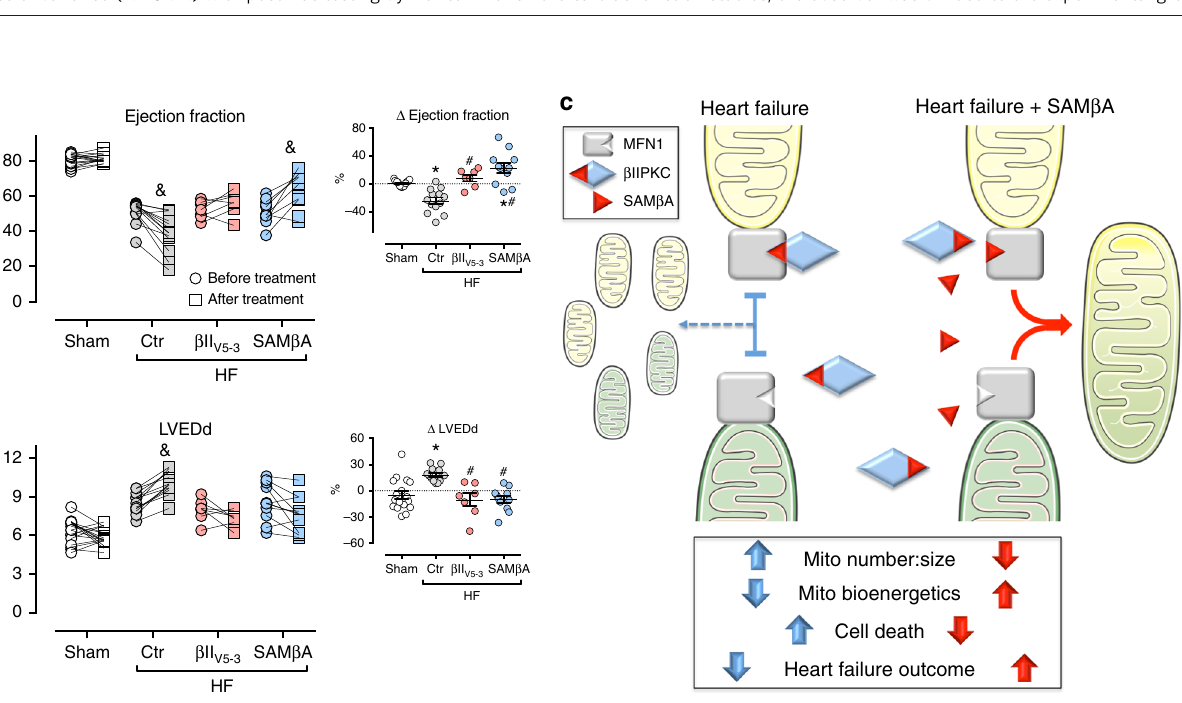
Fig. 6 SAM β A treatment reduces mitochondrial fragmentation in heart failure. a Schematic panel of heart failure induction by myocardial infarction (MI) and the treatment protocol. Twelve-week-old male rats were subjected to MI-induced heart failure by left anterior descending coronary artery permanent ligation. Four weeks after MI induction, the rats were treated with the either SAM β A peptide (a selective antagonist of Mfn1- β IIPKC association) or with a control peptide (TAT, used to deliver SAM β A into the heart). Peptide treatment was continuous for 6 weeks using an Alzet pump delivery at 3 mg per Kg per day. b Left ventricular ejection fraction and c LVEDd [left ventricular end-diastolic dimension] measured by echocardiography at the end of the experimental protocol, input: delta of measurements performed before and after treatment; d representative cardiac transmission electron micrographs (scale bar: 1 μ m); e quanti fi cation of mitochondrial number and area in the transmission electron micrographs, the analysis was done in a blinded fashion; f mitochondrial respiratory control ratio, g state 3-dependent oxygen control rate, h absolute H 2 O 2 release and i H 2 O 2 :O 2 in heart samples from sham (white bars, n = 7), TAT-treated heart failure (HF-Ctr, gray bars, n = 8), and SAM β A-treated heart failure (HF-SAM β A, blue bars, n = 11). j Cardiac mitochondrial β IIPKC immunoprecipitate probed against anti- β IIPKC, Mfn1 and phosphorylated serine/threonine antibodies; and β IIPKC immunoprecipitate from heart lysate probed with anti- β IIPKC, troponin I and phosphorylated troponin I antibodies (representative blot of three independent experiments) from